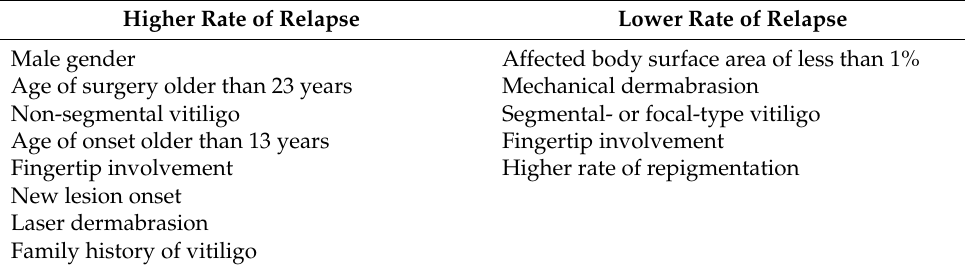
Table 1. Predicting factors following epidermal cell